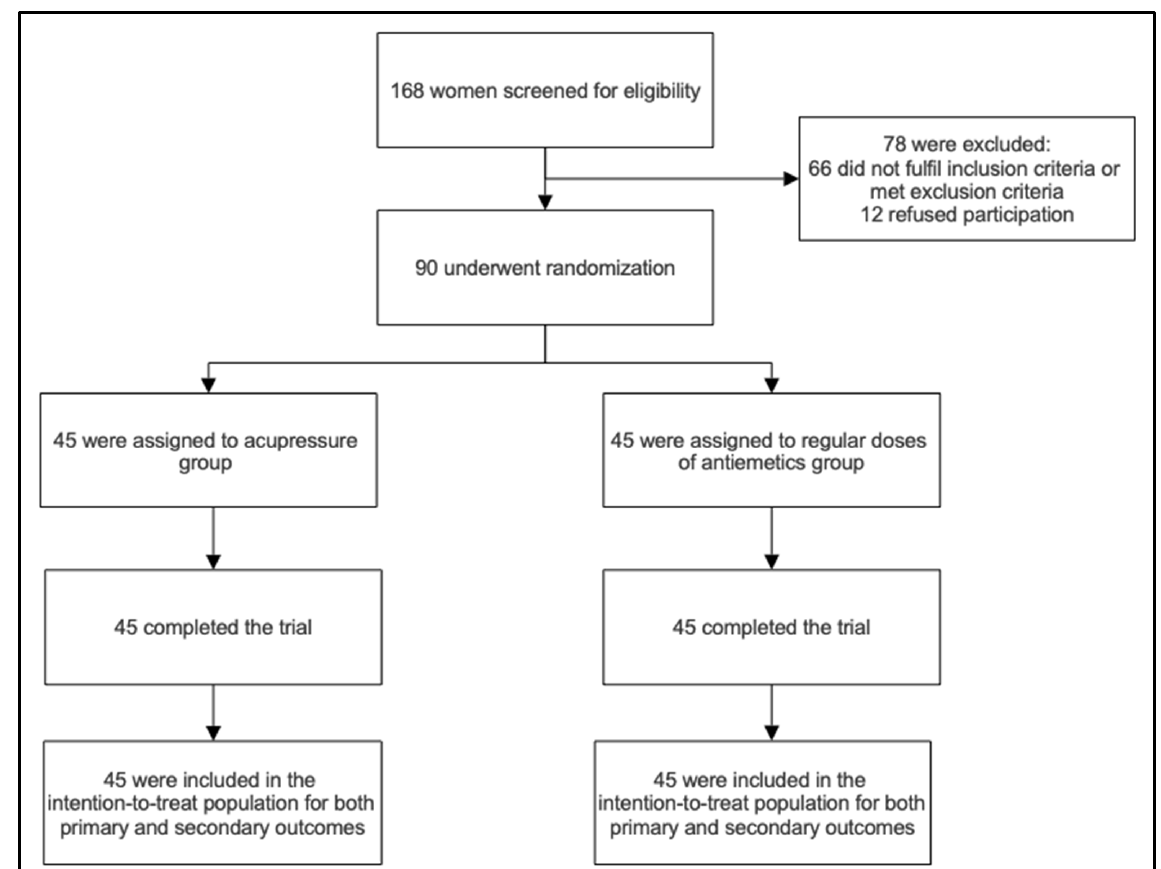
Figure 2. Enrollment and randomization flow chart. Table 1. Baseline characteristics of participants.